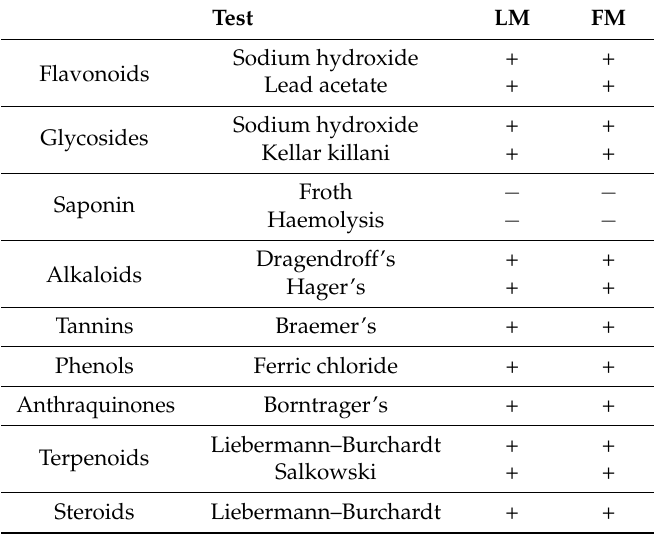
Table 3. Qualitative phytochemical screening of both Antirrhinum majus